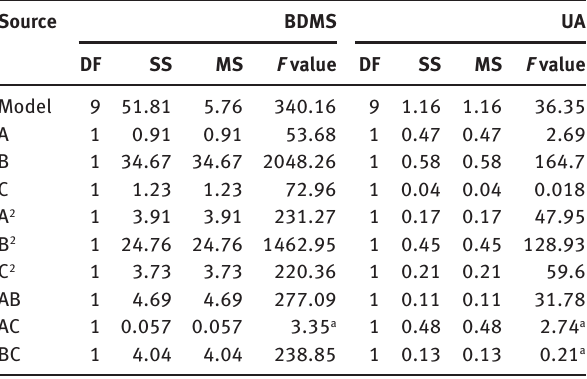
Table 2: Analysis of variance for response surface quadratic model for amount of β , β -dimethylacryl shikonin (BDMS), ursolic acid (UA).